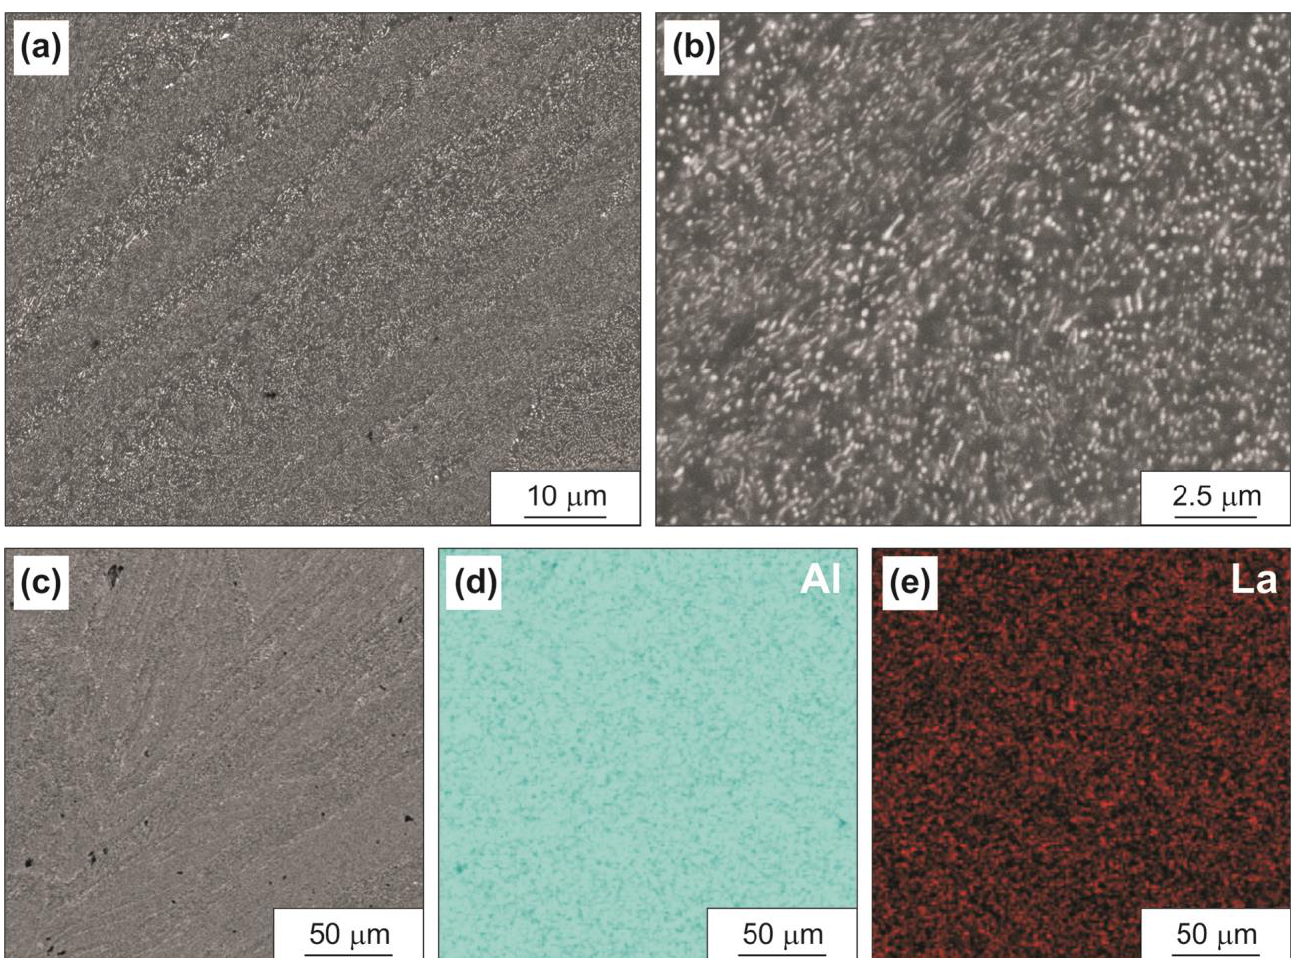
Figure 2. ( a ) The appearance and ( b ) cross section of the 5-mm diameter composite sample.